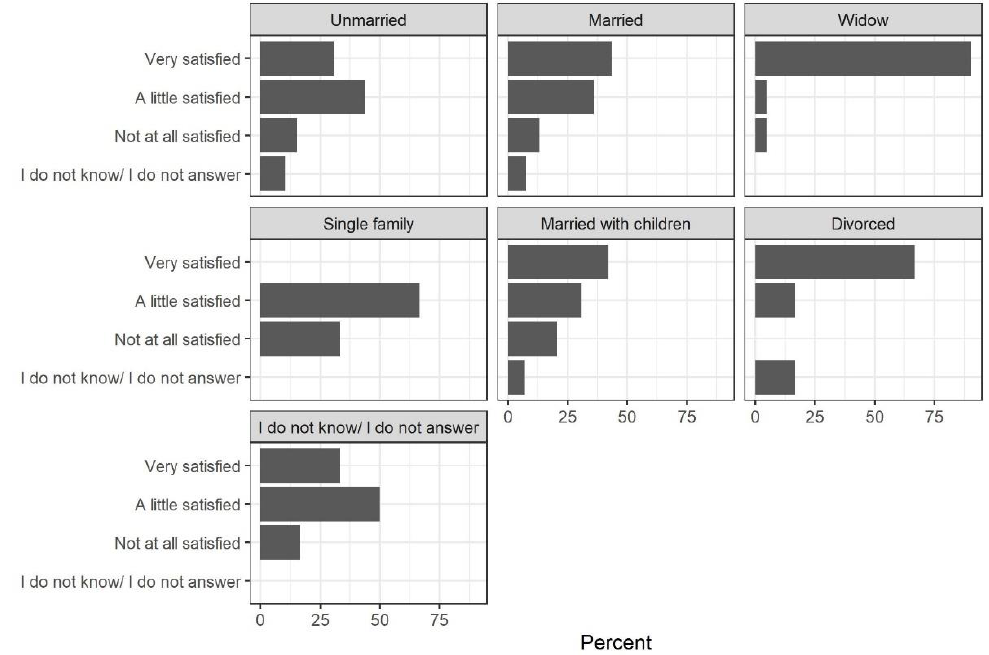
Figure A10. Cross-tabulation of attitudes of believers about the reopening of the Churches by marital status (% by marital status). Χ 2 = 37.37, df = NA, p = 0.008 (Pearson’s Chi-squared test with simulated p -value based on 2000 replicates).